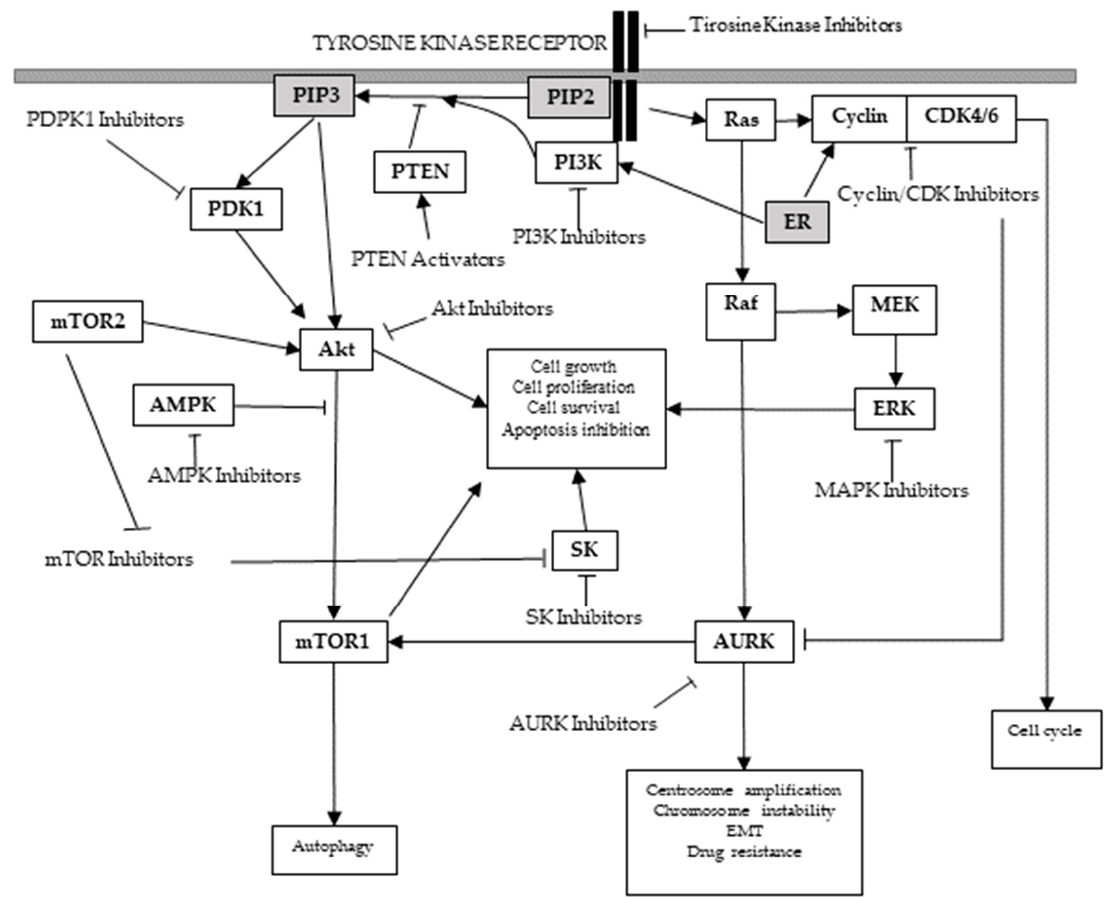
Figure 3. Main altered protein kinase pathways in breast cancer. ( → : Activation; T: Inhibition)